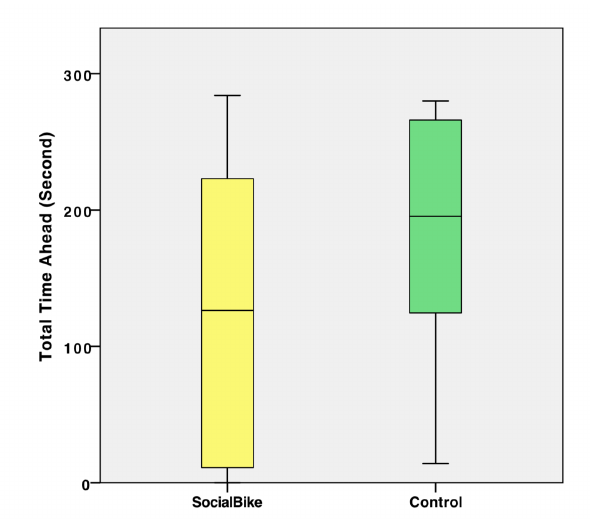
Figure. 18. The result of Total time within 5 meters Figure. 20. The result of Total Time Ahead (second) (second) Average Distance Behind (meter) Participants’ average distance to the virtual when riding behind in experiment scenario (Mean=7.024, SD=3.053) is shorter than in control scenario (Mean=9.577, SD=5.810). However, the difference is not significant t(19)=-2.083, p=0.051 (Figure. 21).